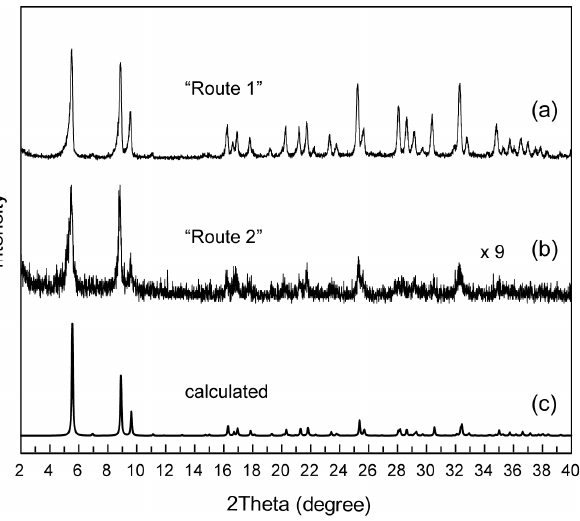
Figure 3. Powder XRD patterns of C 12 N 2 -H 2 W 12 hybrid crystals: ( a ) colorless precipitate of C 12 N 2 - H 2 W 12 obtained using “Route 1”; ( b ) colorless crystals of C 12 N 2 -H 2 W 12 obtained using “Route 2”; and ( c ) calculated pattern from the crystal structure of C 12 N 2 -H 2 W 12 obtained using “Route 3”.